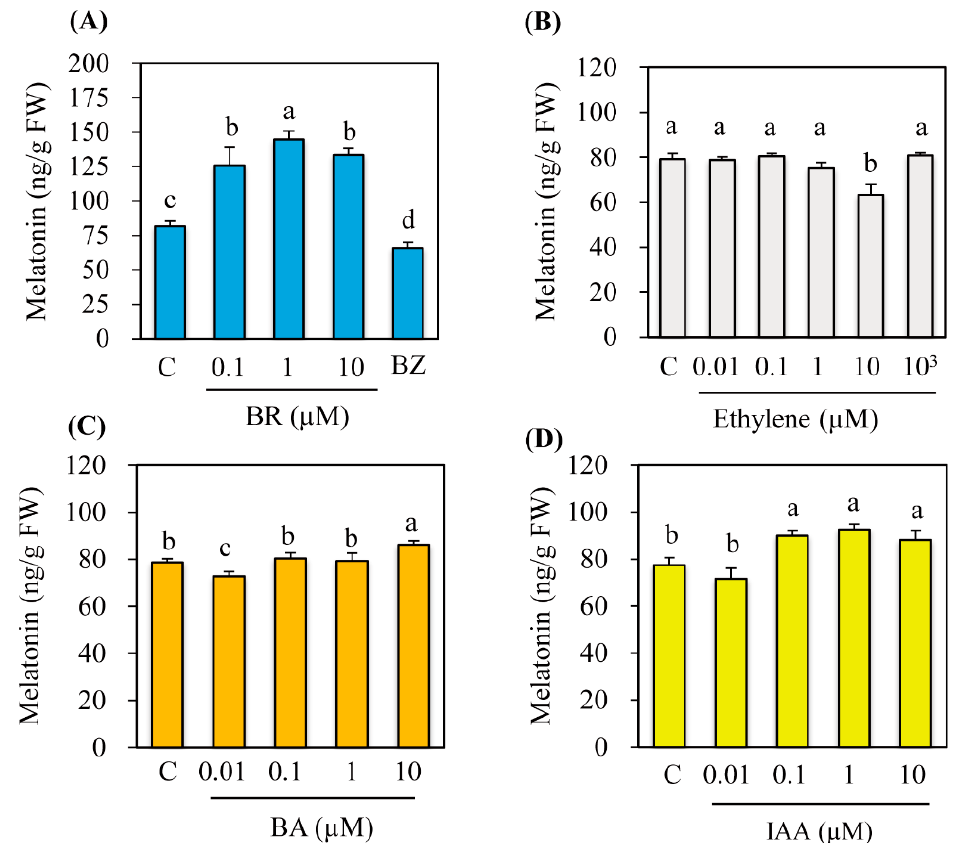
Figure 1. Effects of various hormones on melatonin synthesis. ( A ) Effects of BR on melatonin con-